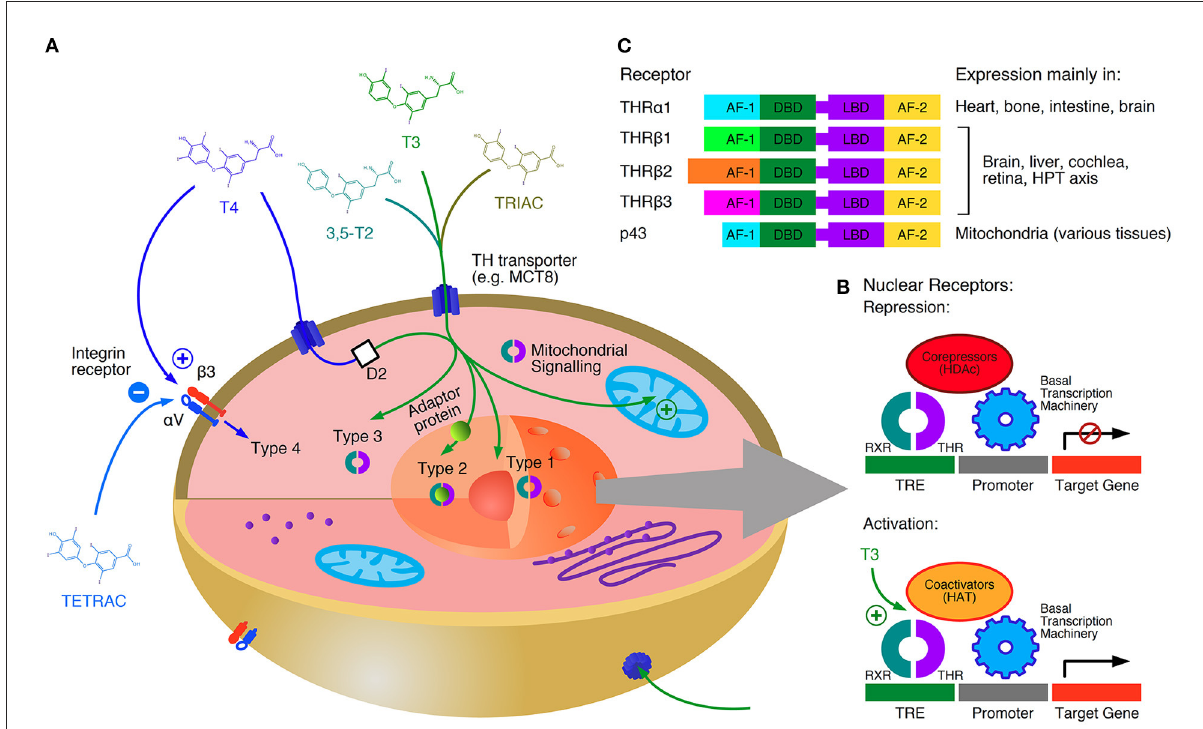
FIGURE1 Types and mechanisms of thyroid hormone signaling. T4 is a prohormone with respect to genomic signaling, but a true fast-acting hormone regarding type 4 action (which is inhibited by the iodothyroacetate TETRAC). Genomic action (type 1, type 2 and mitochondrial signaling) occurs on a slow time scale, whereas non-genomic effects (type 3 and type 4 signaling) represent a fast response (A) . Thyroid hormone receptors (THR) usually act as heterodimers. Without thyroid hormone bound they block the transcription together with corepressors. Iodothyronines displace the corepressors and stimulate gene expression together with coactivators (B) . Tissue specific distributions of THRs further contribute to the diversity of signaling patterns in the organism (C) (48, 65–69). AF-1, activation function 1; AF-2, activation function 2; D2, type 2 deiodinase; DBD, DNA-binding domain; HAT, histone acetyl-transferase; HDAc, histone deacetylase; LBD, ligand-binding domain; RXR, retinoid X receptor; TRE, thyroid-hormone response